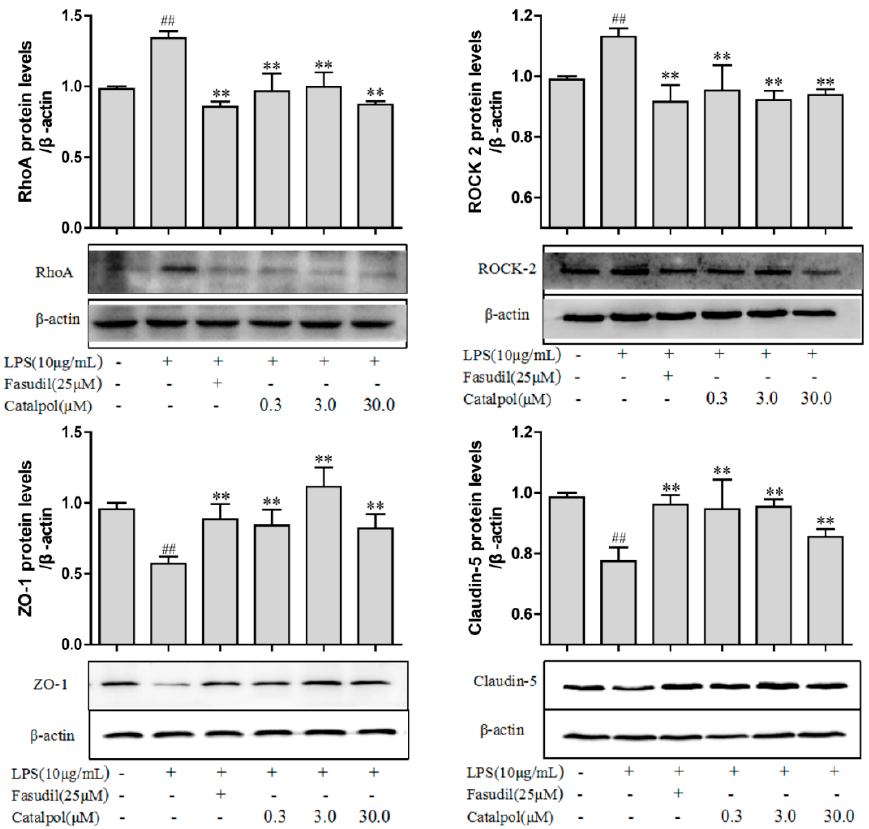
Figure 10. The effects of catalpol on the changes of tight junction and Rho/ROCK pathway proteins expression induced by LPS detected by qPCR ( ± SD, n = 3). ## p < 0.01 vs. the control group; ** p < 0.01, vs. the LPS group.